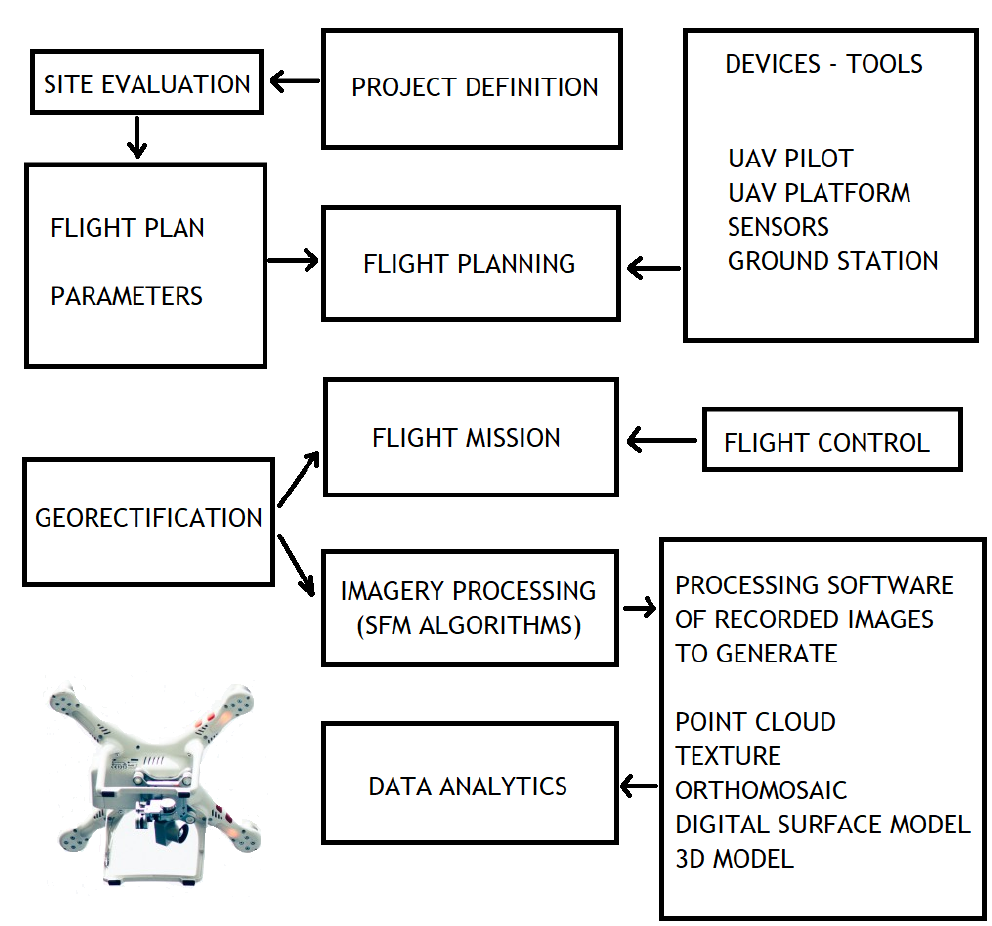
Figure 5. The typical steps followed for UAV-based photogrammetric studies.